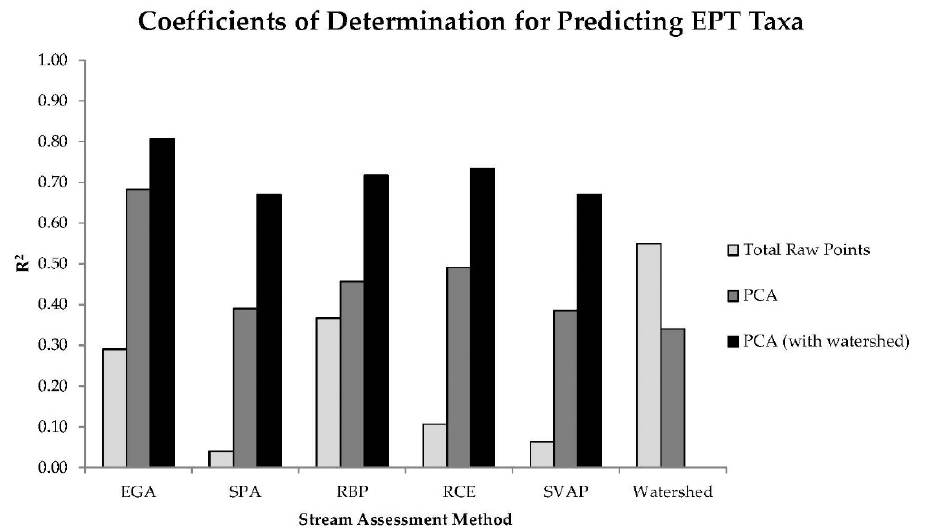
Figure 5. Coefficients of determination (R 2 ) resulting from prediction of EPT taxa values for 65 streams using three linear models of five rapid assessment methods and watershed variables including: (1) total raw points, (2) PCs from PCA of individual variables, (3) PCs from PCA of individual variables combined with watershed parameters. Table 7. Akaike’s Information Criterion (AIC) scores and cross-validation (CV) scores for three linear models to predict EPT taxa by five separate stream assessment methods and by watershed variables. The number of predictors (#) is also provided for each model.